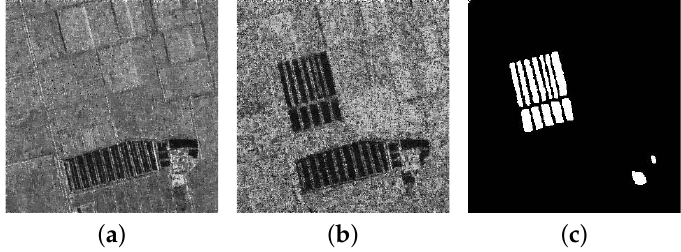
Figure 10. Multitemporal images relating to Farmland C of the Yellow River Estuary and the reference image. ( a ) Image acquired in June 2008. ( b ) Image acquired in June 2009. ( c ) The reference image.